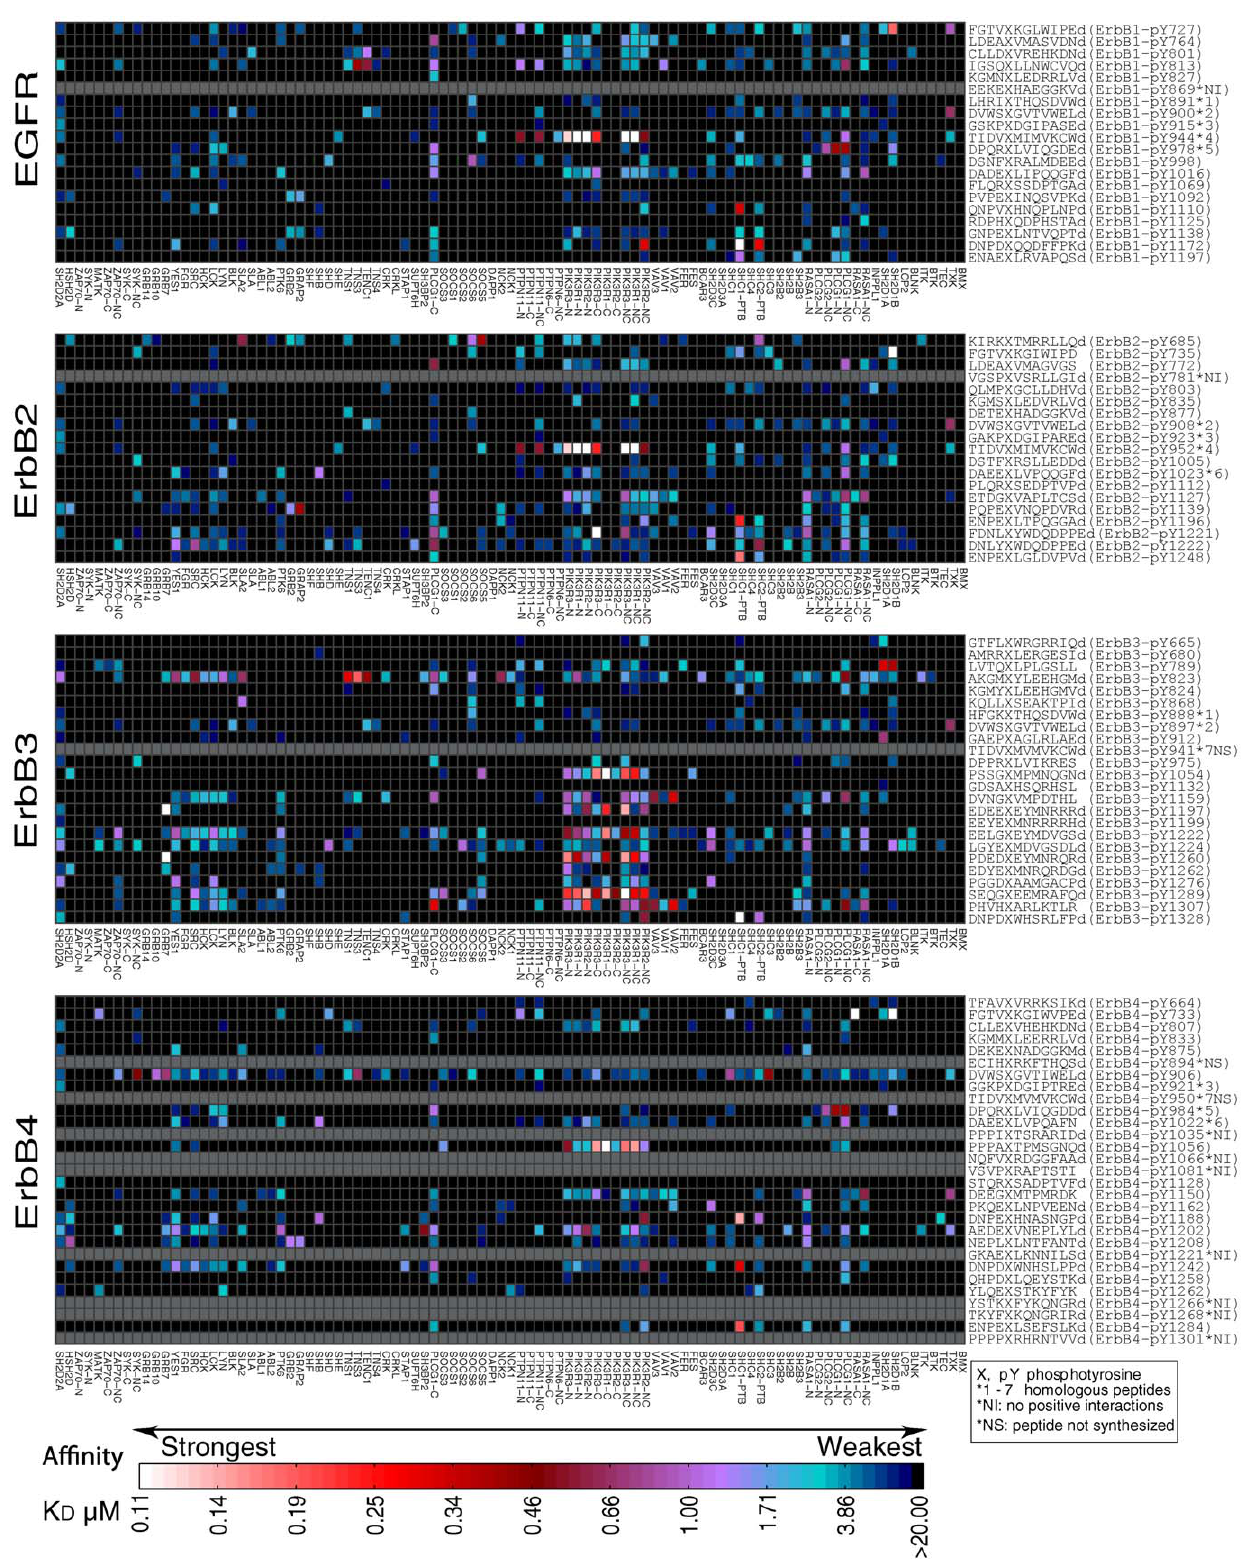
Figure 2. Comprehensive SH2 domain recruitment potential of the ErbB family as determined by high-throughput fluorescence polarization (HT-FP). Color-coded heat maps represent apparent dissociation constants (K D s) for FP interactions between SH2/PTB domains and phosphopeptides representing all potential ErbB1, ErbB2, ErbB3, and ErbB4 phosphotyrosine sites; black boxes indicate interactions that are too weak to be detected by the assay. Homologous ErbB peptides with identical amino acid residues from + 1 to the + 4 position relative to the